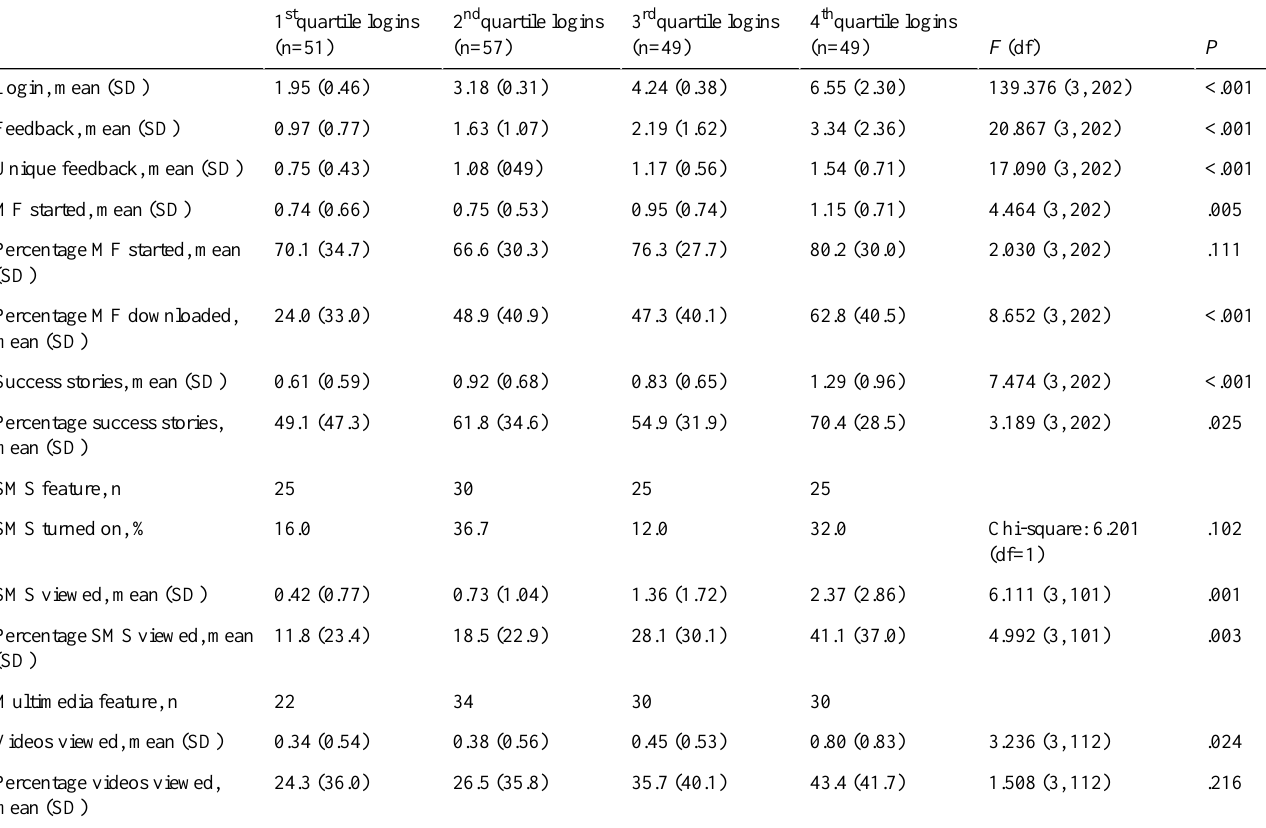
Table 3. Mean logins and mean use of features, for different users (1 st -4 th quartile, n=206).